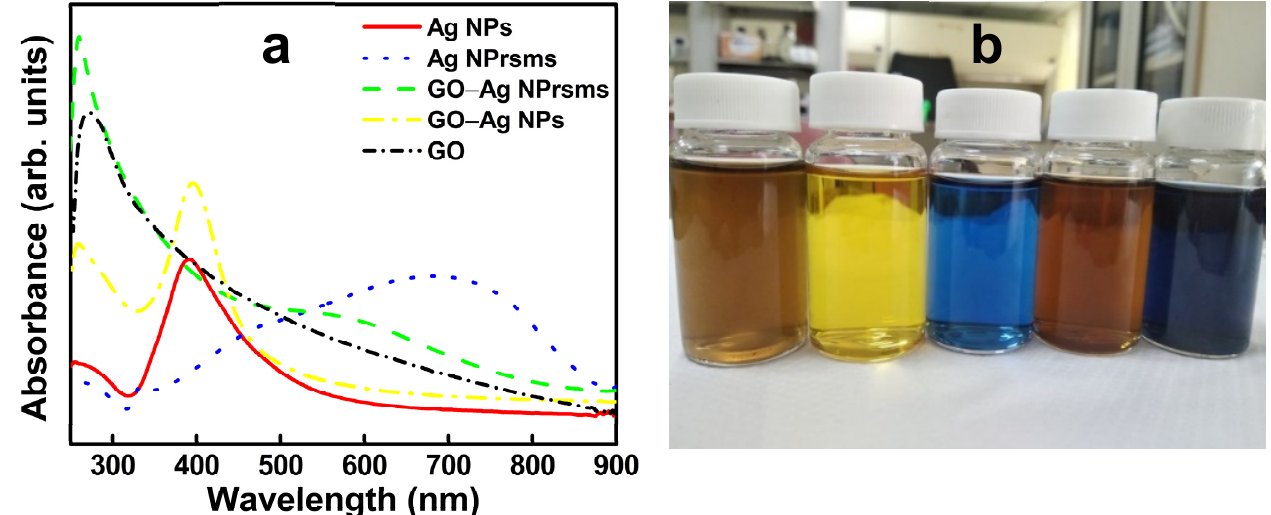
Figure 1. UV-vis spectra ( a ) and photo of nanomaterial suspensions ( b ) of GO, Ag NPs, Ag NPrsms, GO–Ag NPs, and GO–Ag NPrsms (from left to right).